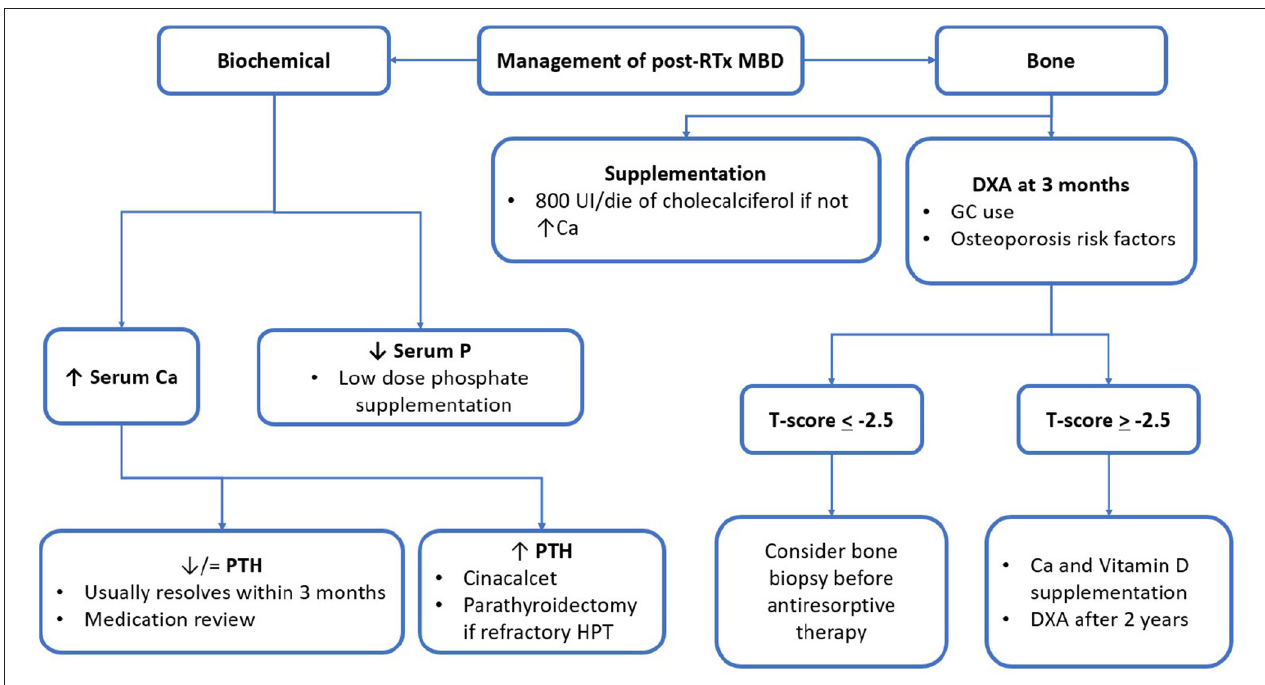
FIGURE 2 | post-RTx MBD monitoring and management algorithm. RTx, renal transplantation; MBD, mineral bone disorder; GC, glucocorticoid; UI, international unit; eGFR, estimated glomerular filtration rate; Ca, calcium; P, phosphorus; PTH, parathormone; ABD, adynamic bone disease; DXA, dual-energy